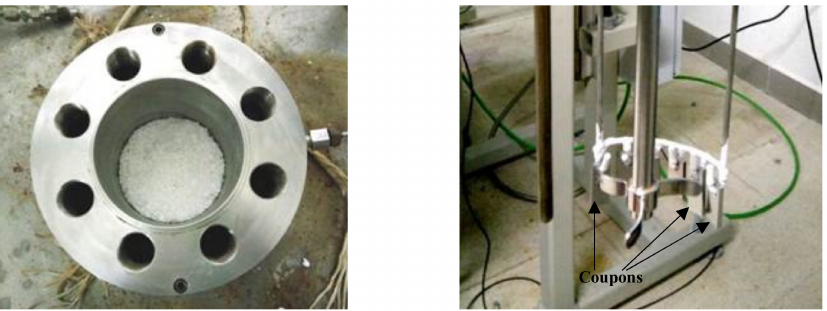
Figure 1. Autoclave filled with the lithium ternary molten salt ( left ) and detail of the rack with alloys specimens and the mixer ( right